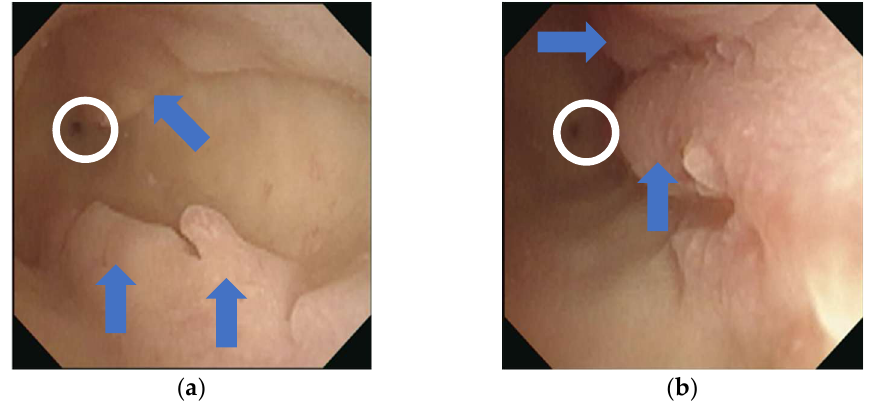
Figure 3. Hysteroscopy images: Intact ostium of the fallopian tube (white ring) and multiple endometrial polyps (blue arrows) are visible in the bilateral (right ( a ) and left ( b )) uterine cavities. Given that the endometrial biopsy results of left uterus showed CD138 positive cells on immune-histological examination (Figure 4), and a chronic endometritis (CE) diagnosis score of 1 according to McQueen’s classification [8], she was administered doxycycline for 14 days.